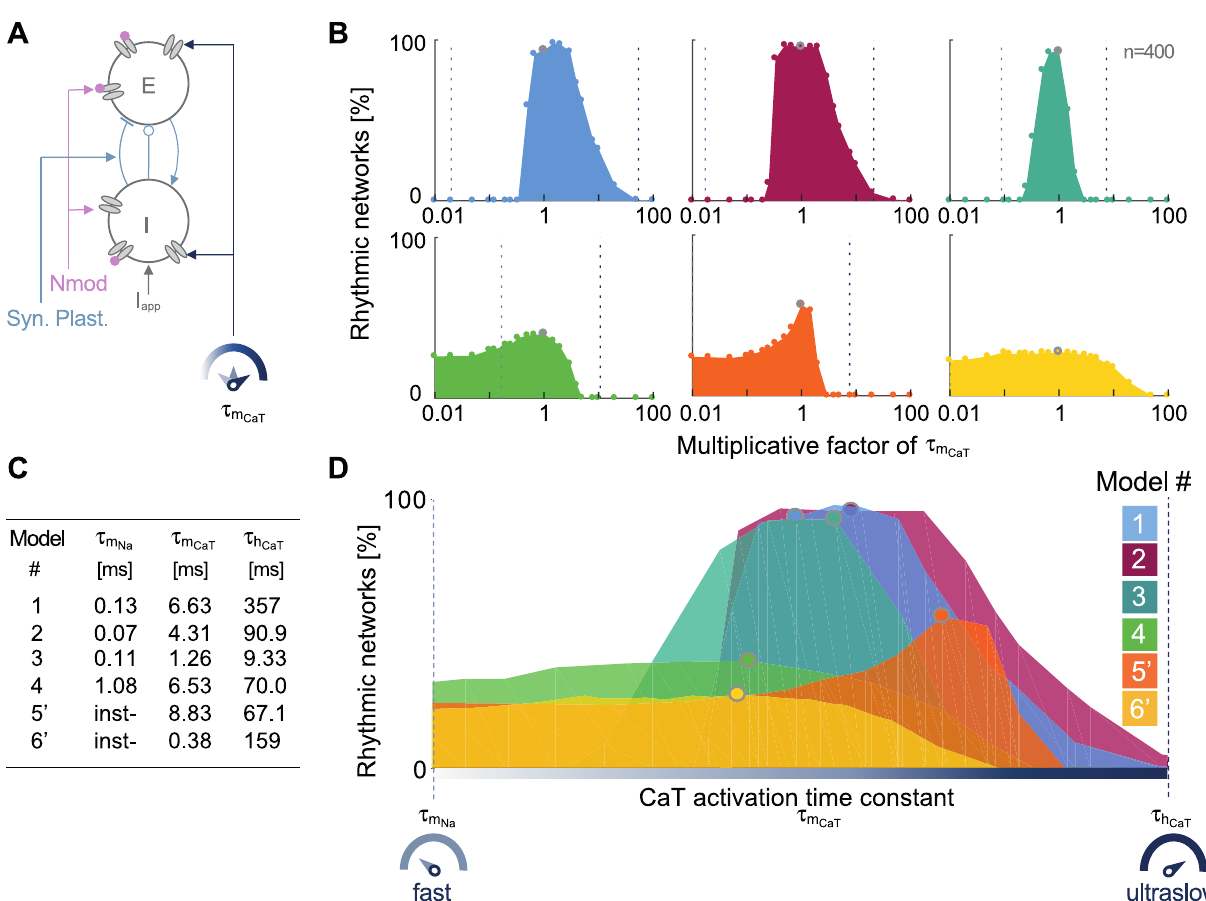
Fig 3. The physiological slow timescale of T-type calcium channel activation guarantees compatibility between circuit switch, neuromodulation and synaptic plasticity. A : For each model, 400 E-I 2-cell circuits are built from scaled intrinsic and synaptic conductances picked in a uniform range of ± 20% around their nominal values to mimic neuromodulation and synaptic plasticity. These same 400 circuits are then simulated for a varying CaT channel activation time constant ( t ). B : Comparison table between the time constants associated with sodium channel activation ( t m CaT activation and CaT channel inactivation ( t ). C : Effect of a varying CaT channel activation time constant on the switching capability in a 2-cell circuit h CaT for models 1, 2, 3, 4, 5’ and 6’. The y-axis quantifies the percent of rhythmic networks among the 400 simulated random circuits under different values of t , scaled by a multiplicative factor varying from 0.01 to 100. The performance associated with the nominal (resp. scaled) CaT channel activation is m CaT depicted with a gray circle (resp full circle). The sodium channel activation (resp. CaT channel inactivation) time constant is marked with the left (resp. right) dashed vertical line. D : Each model is superposed between a window bounded on the left (resp. right) by the sodium channel activation (resp. CaT channel inactivation) time constant. The CaT activation time constant must remain confined in the slow timescale in order to guarantee model robustness to neuromodulation and synaptic plasticity.